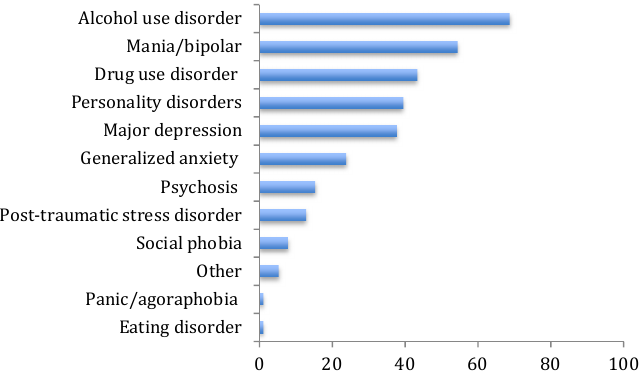
Figure 1. Mental health disorders where gambling problems most frequently occur according to clinicians.